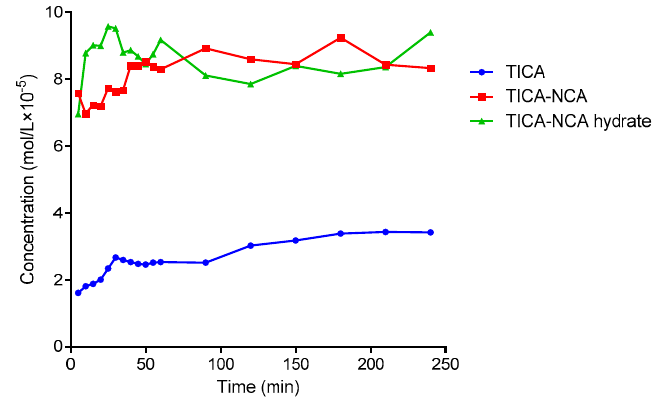
Figure 7. The dissolution rate of TICA, TICA-NCA, and TICA-NCA hydrate.